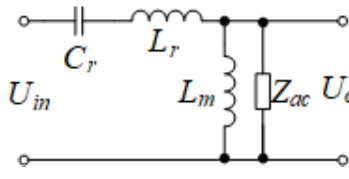
Figure 2. Simplified two-port